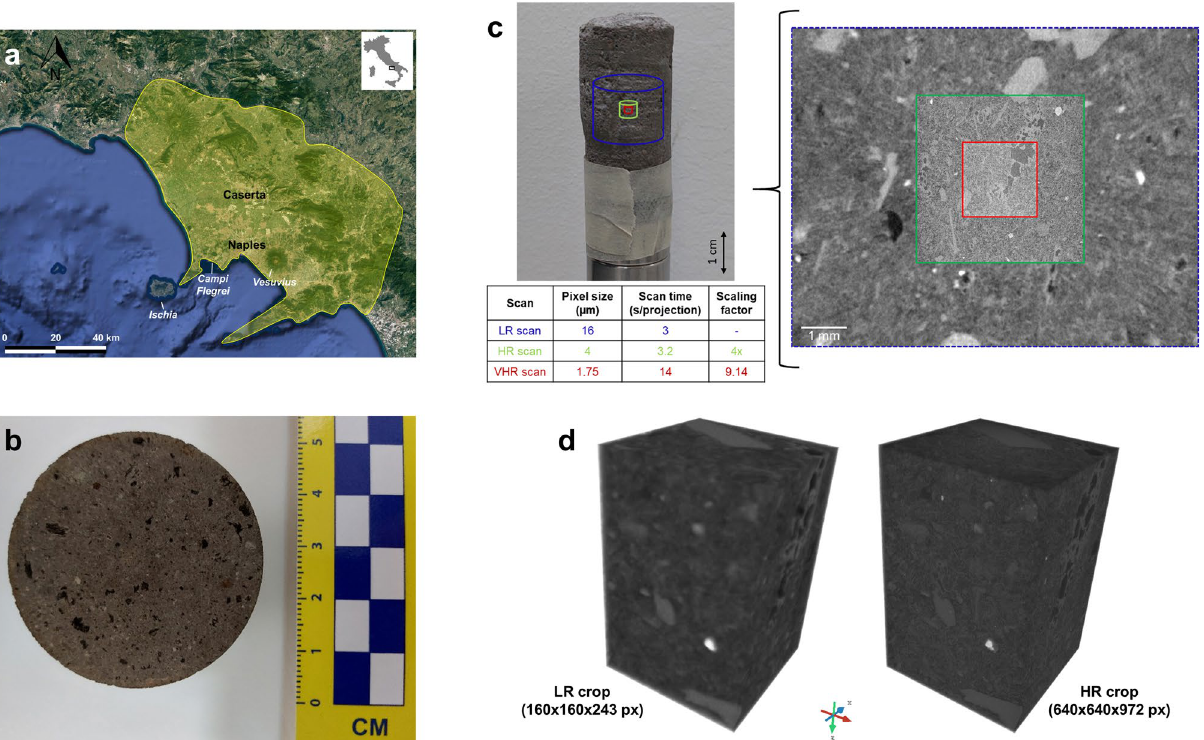
Figure 1. Location, distribution, aspect and 3D imaging of Campanian Ignimbrite tuff. ( a ) Area covered by Campanian Ignimbrite pyroclastic density currents on land (drawn in yellow following the constrains of Silleni et al. 26 on map from Google Earth Pro 7.3.6: https:// www. google. com/ earth/ about/ versi ons/). ( b ) Cross-section of a core (diameter: 54 mm, height: 103 mm) from the Campanian Ignimbrite tuff employed for laboratory measurement. ( c ) 3D multiscale X-ray imaging. Left: Tuff core (diameter ~ 20 mm, height ~ 40 mm) acquired by X-ray microtomography. Right: 3D scans obtained progressively decreasing pixel sizes and fields of view, and increasing exposure time: low resolution (LR; 16 μm/px), high resolution (HR; 4 μm/px) and very high resolution (VHR; 1.75 μm/px) scans (XZ planes). ( d ) Low resolution (LR) image (input) and its corresponding high resolution (HR) counterpart (ground truth) used to train and validate paired super-resolutions